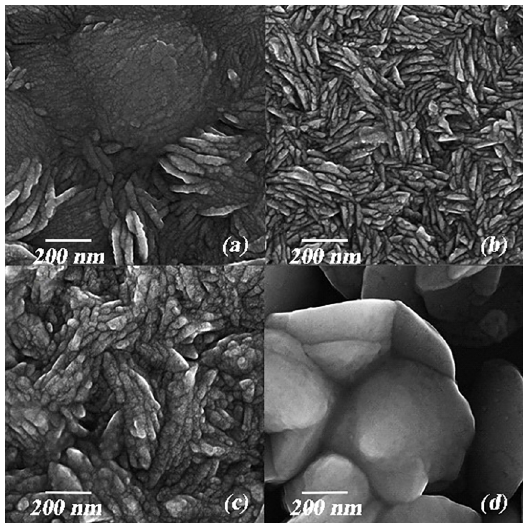
Figure 3. FESEM images of undoped ZnO films deposited at (a) 325℃, (b) 375℃, (c) 450℃, (d) 525℃